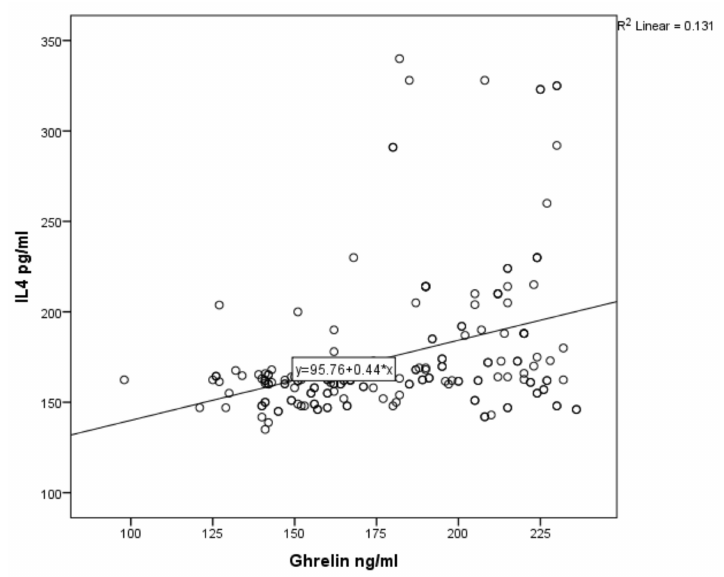
Figure 1. Correlation of serum ghrelin with serum IL-4 in asthmatic children.